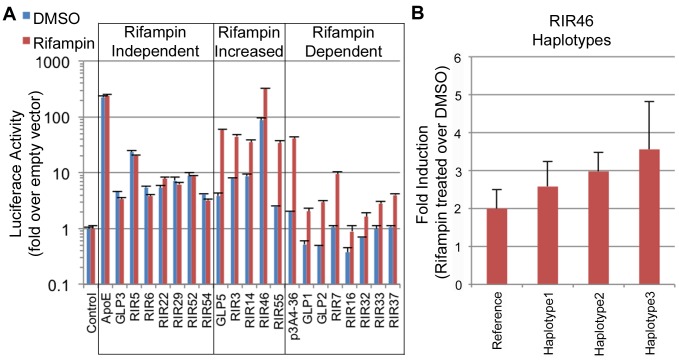
Functional enhancer assays.(A) RIRs or GLPs that showed positive enhancer activity in our assays. These were divided into three classes: 1) rifampin independent, where the addition of rifampin did not change enhancer activity; 2) rifampin increased, where rifampin increased enhancer activity; 3) rifampin dependent, when only upon rifampin treatment did the sequence show significant enhancer activity. An empty vector was used as a negative control and the ApoE liver enhancer [44] and a CYP3A4 promoter-enhancer combination (p3A4-362(7836/7208ins) [24] labeled as p3A4-36, were used as positive controls. (B) Haplotype 3 in RIR46 shows increased enhancer activity (adjusted p-value (FDR) = 0.095 from post test when compared to the reference haplotype; one-way ANOVA).